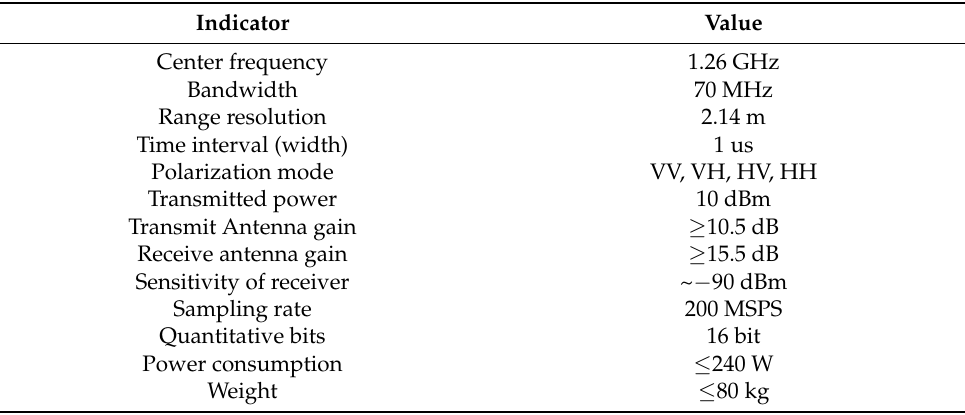
Figure 2. Positive and negative swept linear frequency modulation signal. Table 1. The main parameters of L-band fully polarimetric radar system.